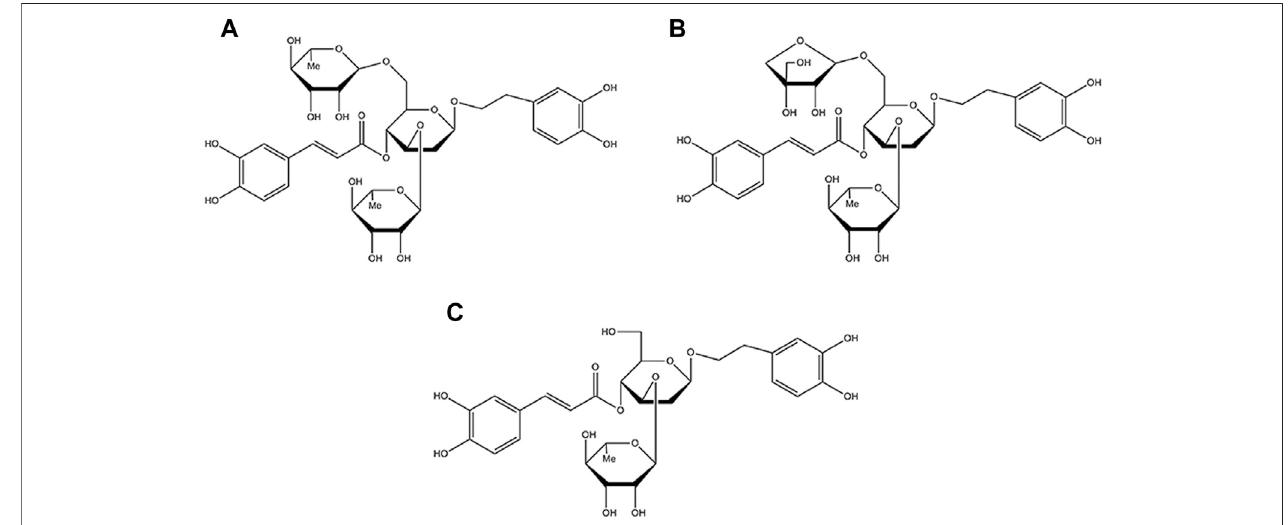
FIGURE 1 | Chemical structure of POL (A) , ACT (B) , FTB (C)